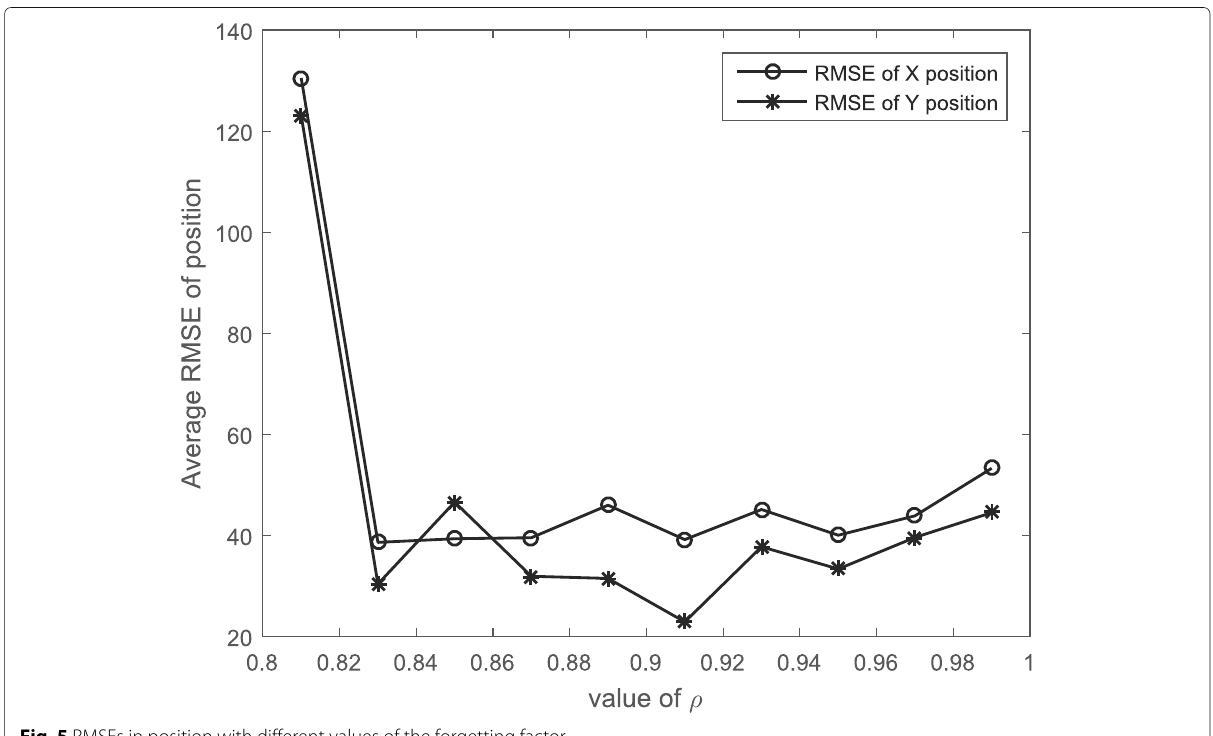
Fig. 5 RMSEs in position with different values of the forgetting factor